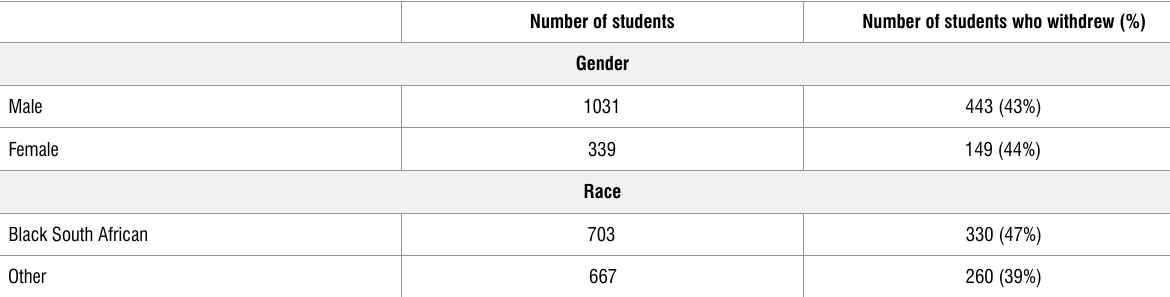
Table 3: Proportion of students who withdrew from engineering, by race and gender ( n =1370) Number of students Number of students who withdrew (%)